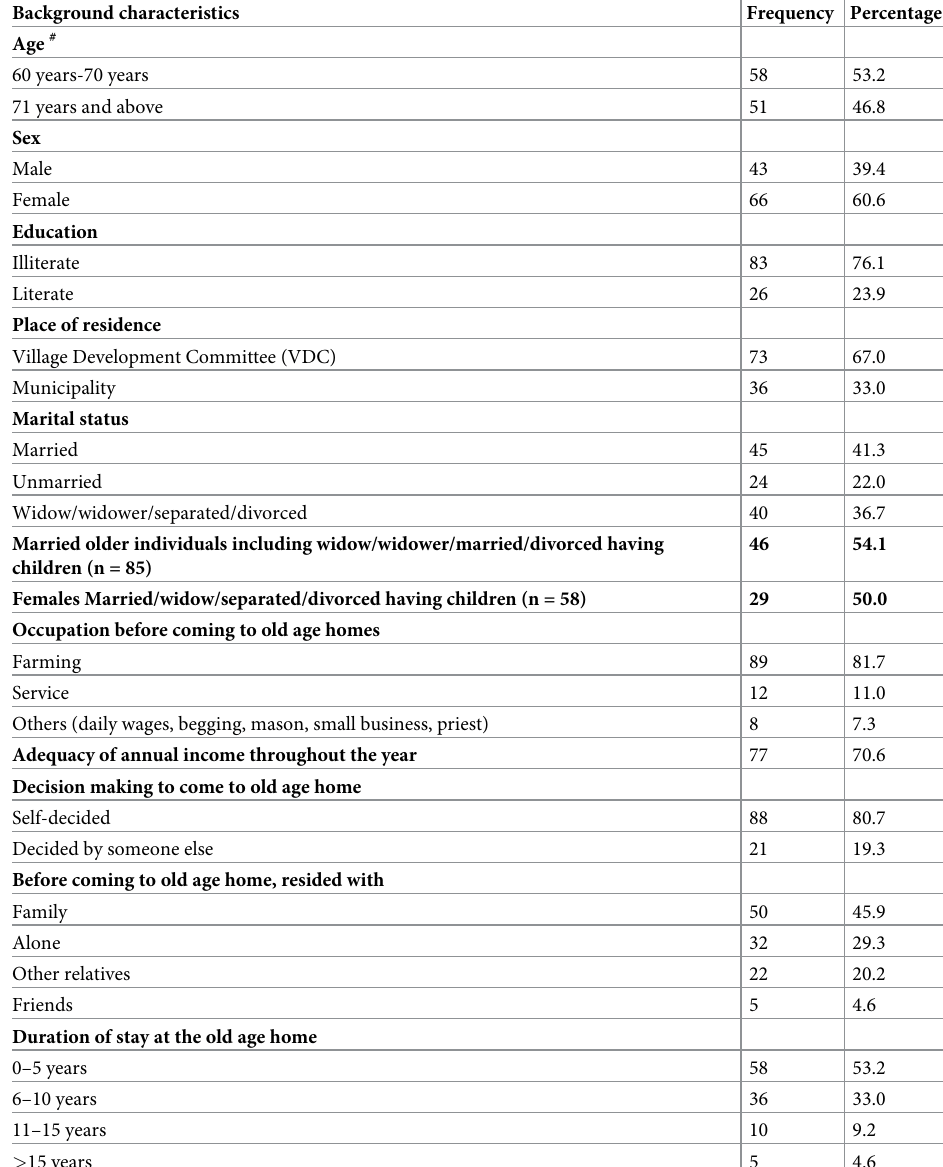
Table 1. Background information of older adults residing in old age homes (n = 109). Background